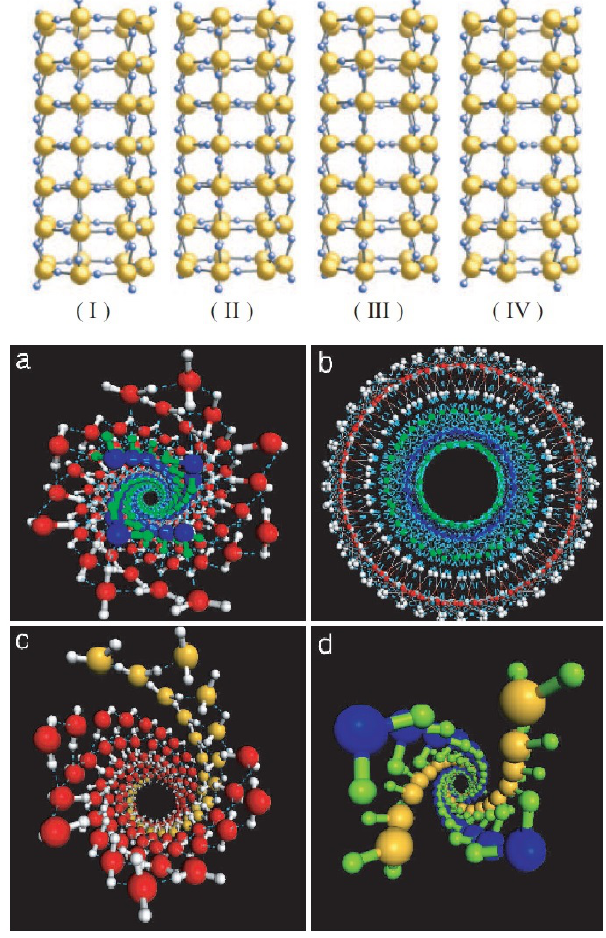
Figure 9. ( Up ) Schematic illustration of the heptagonal ice-NTs with energetically equivalent proton arrangements (I–IV). Larger spheres represent oxygen atoms and smaller spheres represent hydrogen atoms. Reprinted with permission from Ref. [53]. Copyright © 2006 by the American Physical Society. ( Down ) Snapshots of quenched molecular coordinates of the helical nano-ice formed in (17, 0) CNT at 4GPa axial pressure. ( a ) Top view of the double-walled nano-ice helix in the axial direction. Water molecules in the outer wall are in red–white, whereas those in the inner wall are in blue–green (the blue dashed lines denote hydrogen bonds). ( b ) Projected top view in the axial direction. Due to the helicity, the projected top view shows ring-like outer and inner wall structures. ( c ) The outer wall: an octuple-stranded helix consisting of four double helixes (one of the four is highlighted by gold). ( d ) The inner wall: a quadruple-stranded helix where two strands (gold) are proton donors and two (blue) are proton acceptors to molecules of the outer wall. Reprinted with permission from Ref. [169]. Copyright © 2006 National Academy of